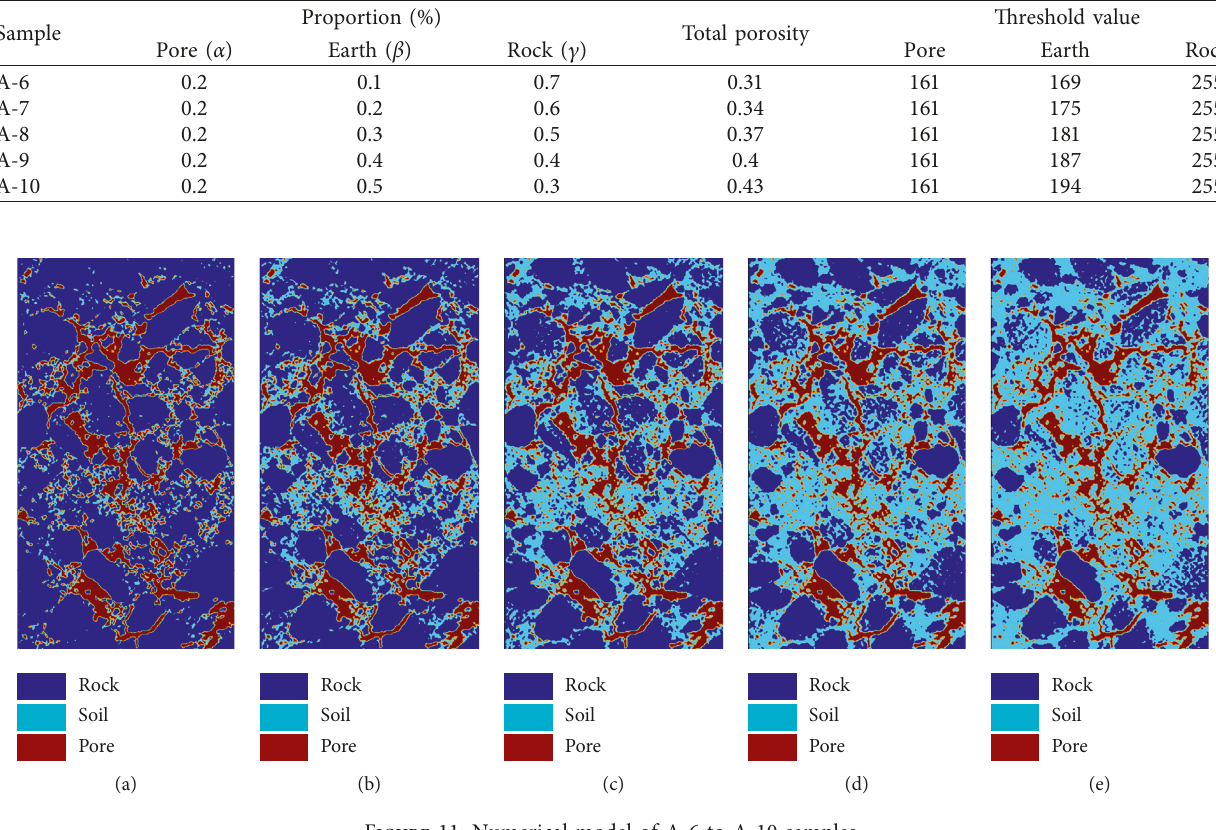
Figure 11: Numerical model of A-6 to A-10